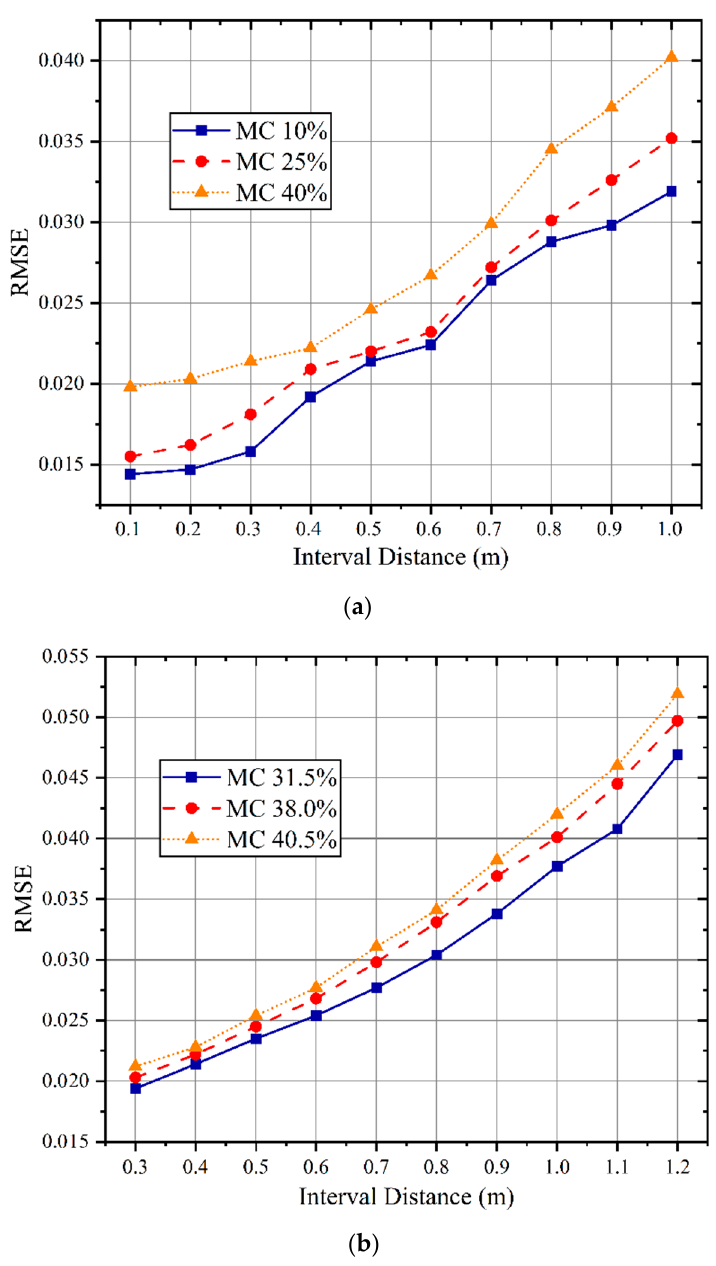
Figure 14. The interval distance vs. RMSE in ( a ) standing cypress and ( b ) the laboratory.